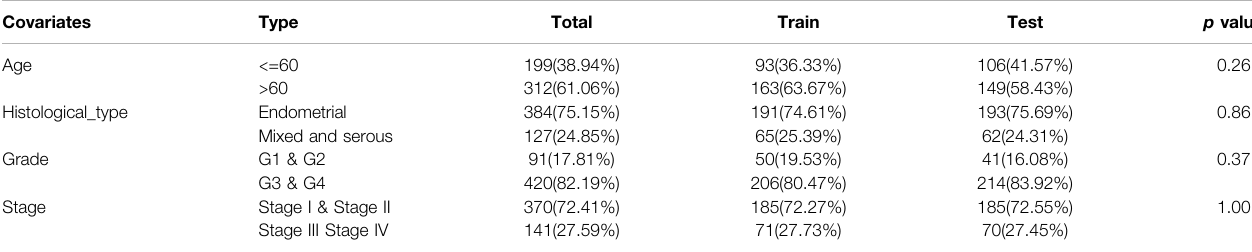
TABLE 1 | Clinical features of included patients.